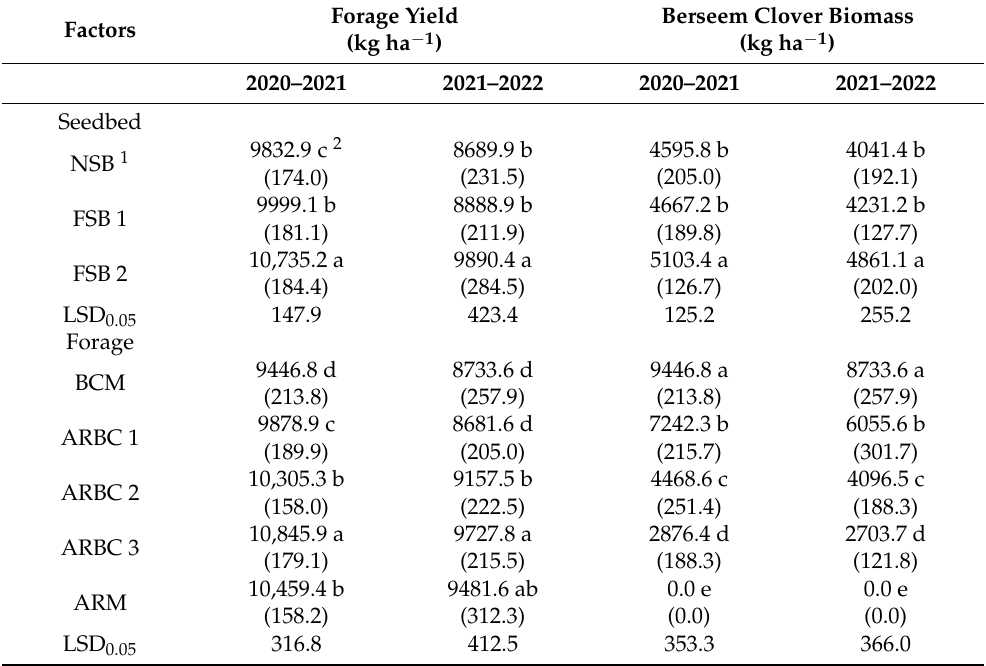
Table 8. Cumulative forage yield (kg ha − 1 ) and biomass of berseem clover (kg ha − 1 ) from two